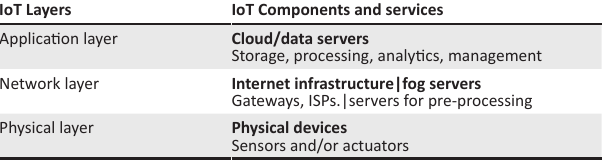
TABLE 1: Layers, stages and components of Internet-of-Things system.